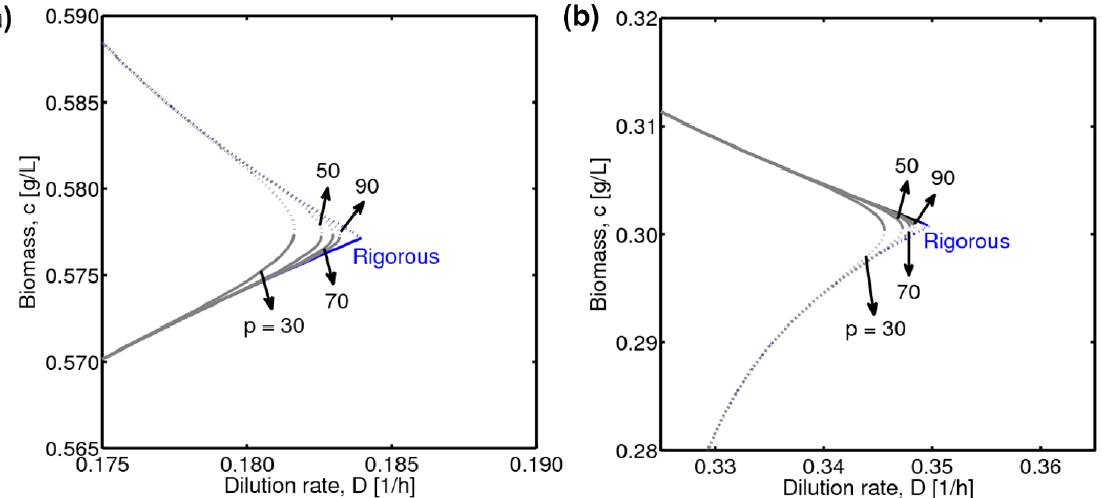
Figure 4. Magnified views of two red windows around the catch-up points in the lower-right panel of Figure 3: ( a ) left upper window, ( b ) right lower